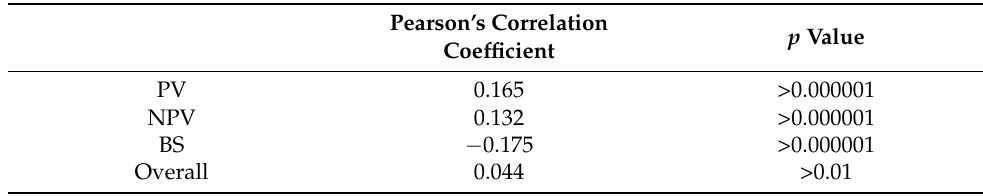
Table 3. Correlation between unmixing error and absolute model prediction error of all field sites ( n =